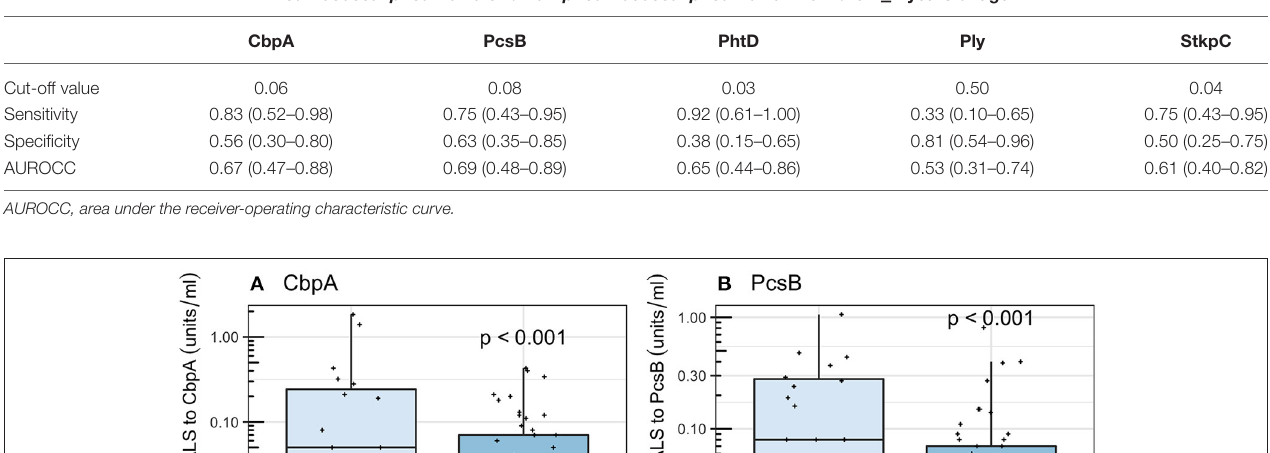
TABLE 4 | Diagnostic accuracy, using thresholds derived from the Youden Index, for acute IgG ALS to pneumococcal proteins to discriminate between pneumococcal pneumonia and non-pneumococcal pneumonia in children ≥ 2 years of age with pneumonia in Nepal.